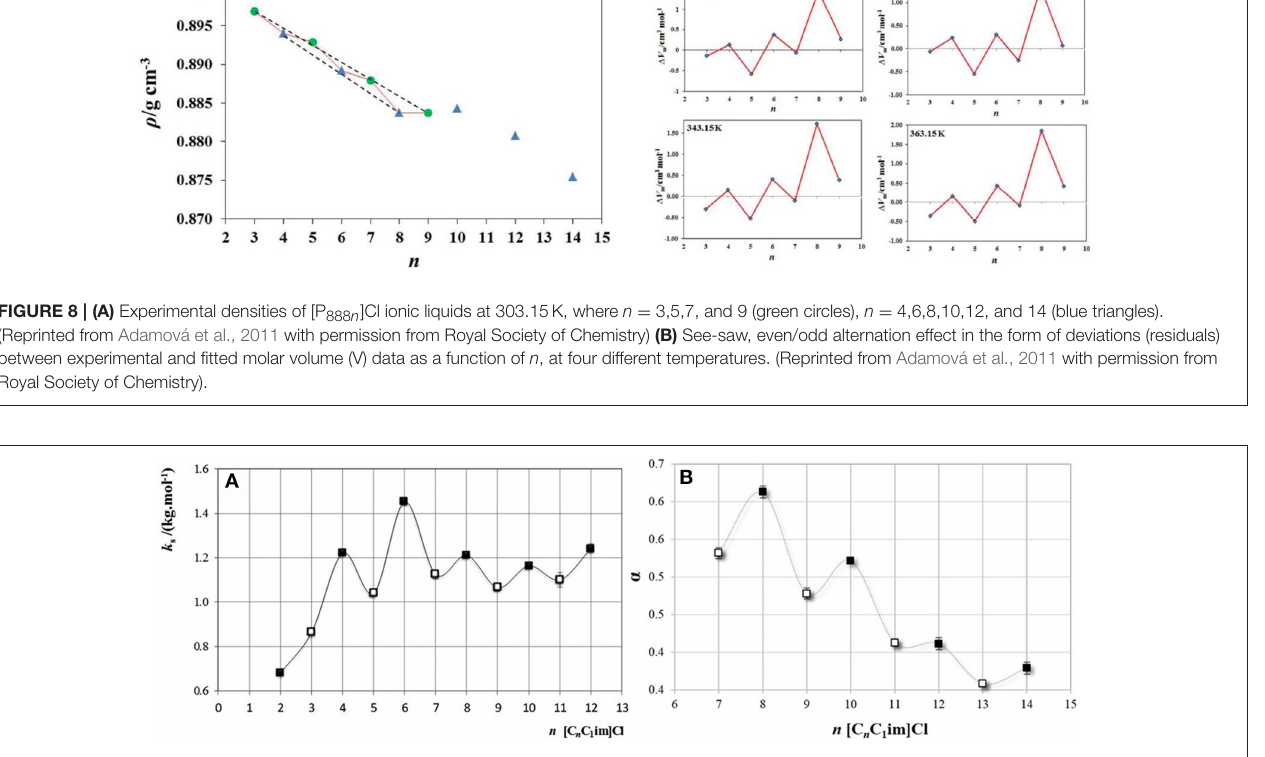
FIGURE 9 | (A) Setschenow constant, ks , as a function of the carbon number at the longest alkyl chain, n , in [C n C 1 im]Cl, for the ABS formed with the salt K 2 CO 3 . (Reprinted from Belchior et al., 2018 with the permission of AIP Publishing) (B) Degree of ionization as a function of the carbon number at the cation alkyl chain, n ,